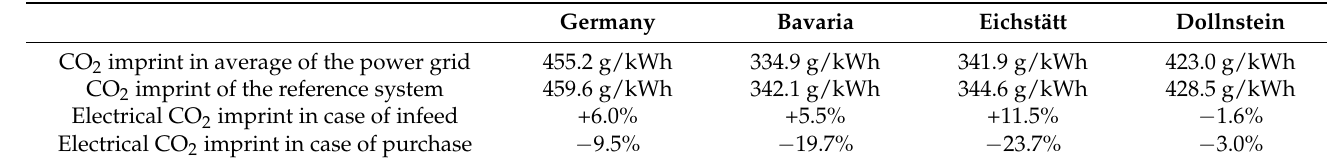
Table 4. CO 2 imprint of the system compared to the heat-controlled reference system by consideration of residual load. The first row reflects the CO 2 emissions of the electricity mix within the individual region throughout the whole period considered. The second row reflects the CO 2 emissions of the electricity mix within the individual region during operation of the reference system. The third row indicates the difference of CO 2 emissions between the regional electricity mix and the electricity provided in case of power infeed (i.e., CHP-only mode). The fourth row indicates the difference of CO 2 emissions between the regional electricity mix and the electricity provided in case of power purchase (i.e., HP-only mode).